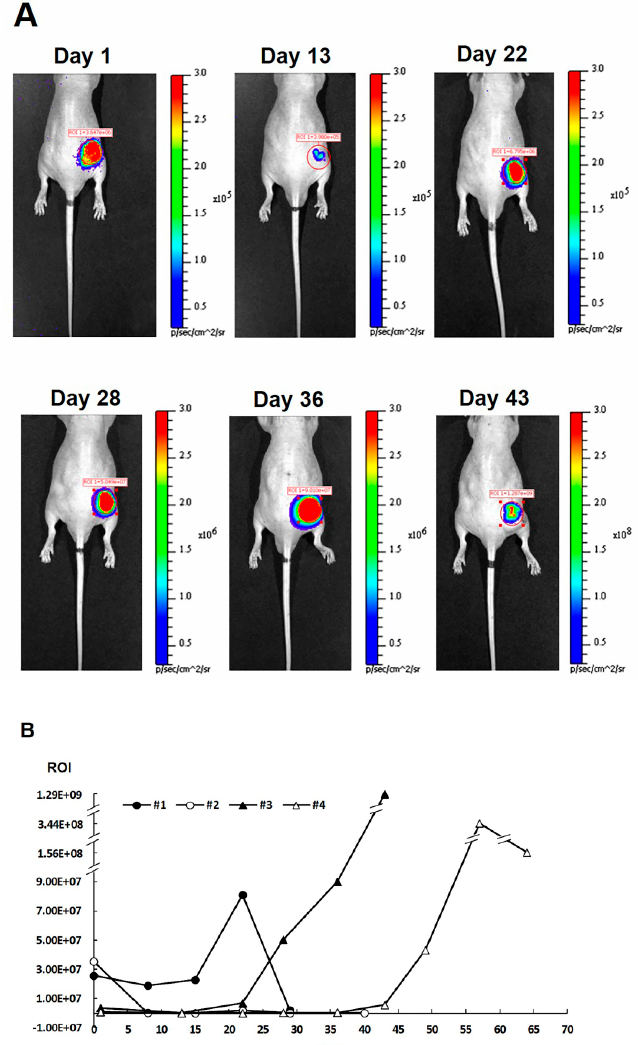
Figure 4. In vivo bioluminescence images of hydrogel and hydrogel-embedded MIN6 cells after subcutaneous transplantation; 5 × 10 6 luciferase-transfected MIN6 cells embedded in mPEG-poly(Ala) hydrogels were subcutaneously transplanted into the right flank of a nude mouse. The hydrogel without MIN6 cells was transplanted into the left flank as a negative control. Recipients were imaged by in vivo imaging system (IVIS). ( A ) The bioluminescence image of a representative recipient. ( B ) The signal intensities (rigion-of-interest, ROI) of bioluminescence images for all recipients.